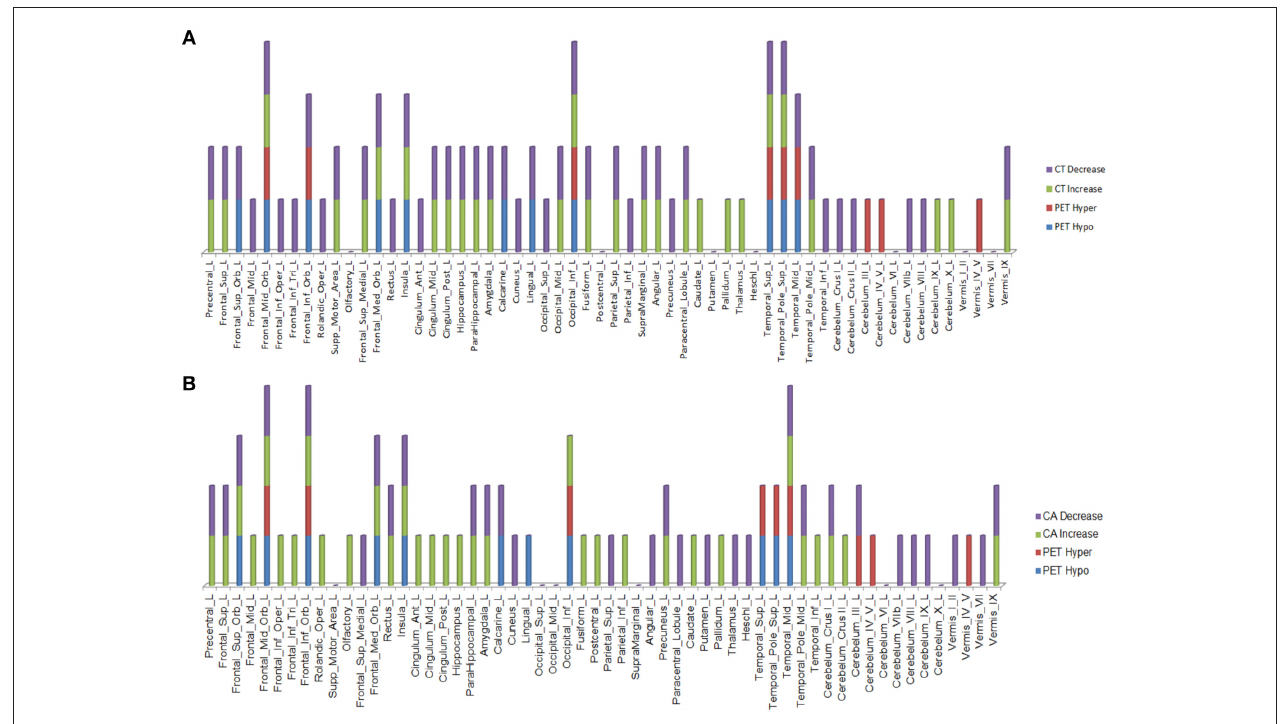
FIGURE 5 | Left hemisphere brain regions with changes in cortical thickness (CT) (A) and cortical area (CA) (B) relative to alterations in 18 F-FDG PET